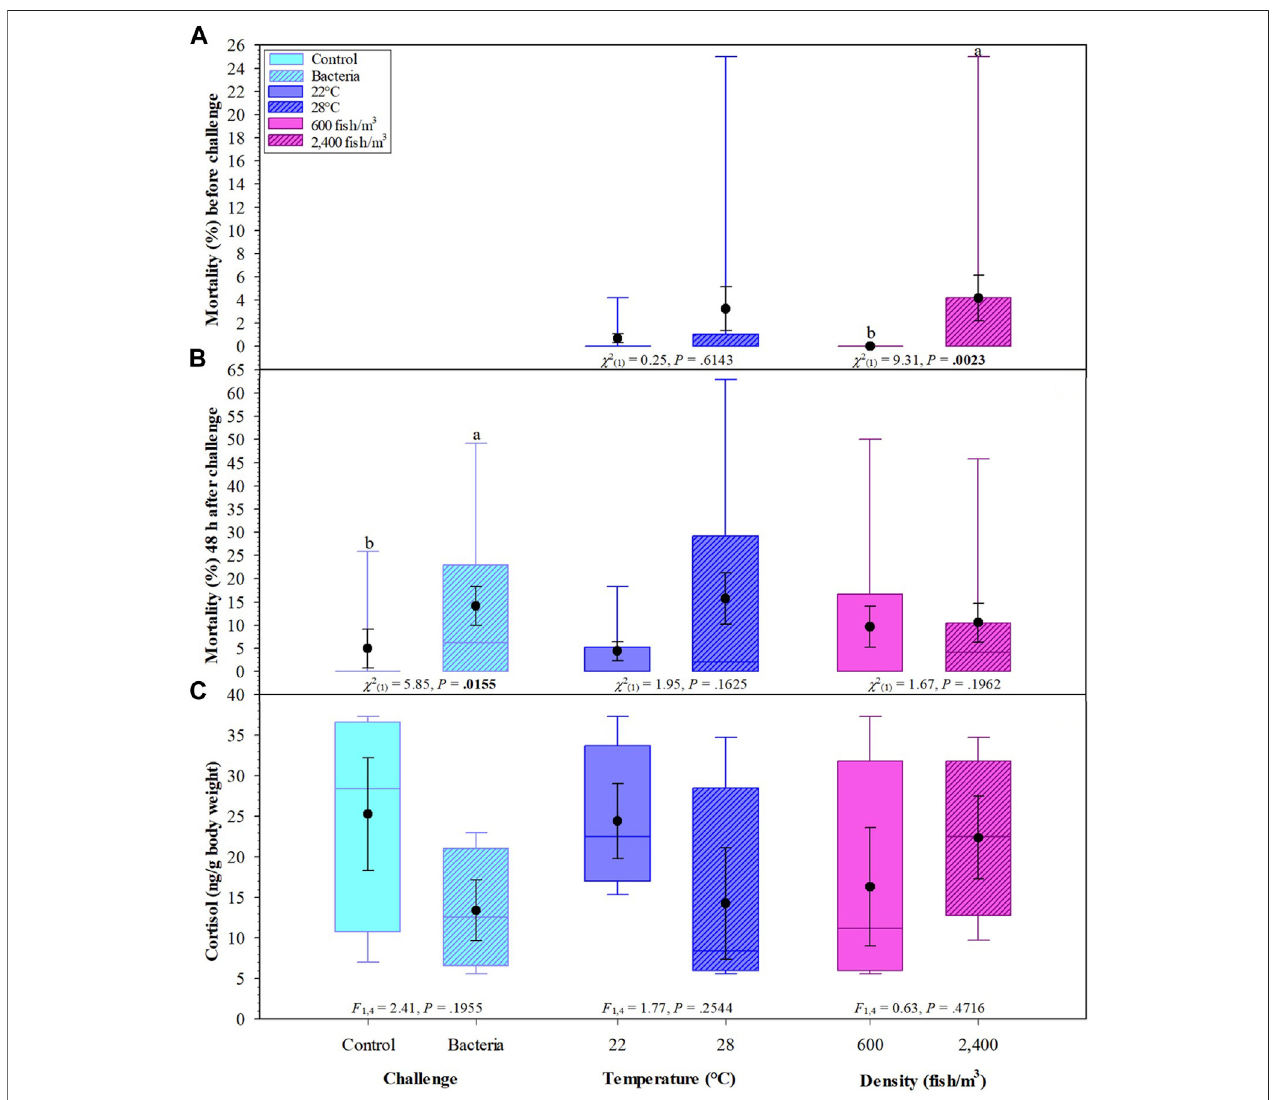
FIGURE2| Effectsofchallenge,temperatures,and fi shdensityofGoldenShinersonmortality(%)beforechallenge (A) ,afterchallenge (B) andwhole-bodycortisol (ng/g body weight) (C) . Golden Shiners were subjected to low (600 fi sh/m 3 ) or high (2,400 fi sh/m 3 ) densities at low (22 ° C) or high (28 ° C) water temperature treatments. Treatments included challenge with F. covae (Bacteria) or no exposure to F. covae (Control). Within each box plot, vertical line indicates the median, black dot indicates the mean, and error bars around the black dot represent standard error of the mean.